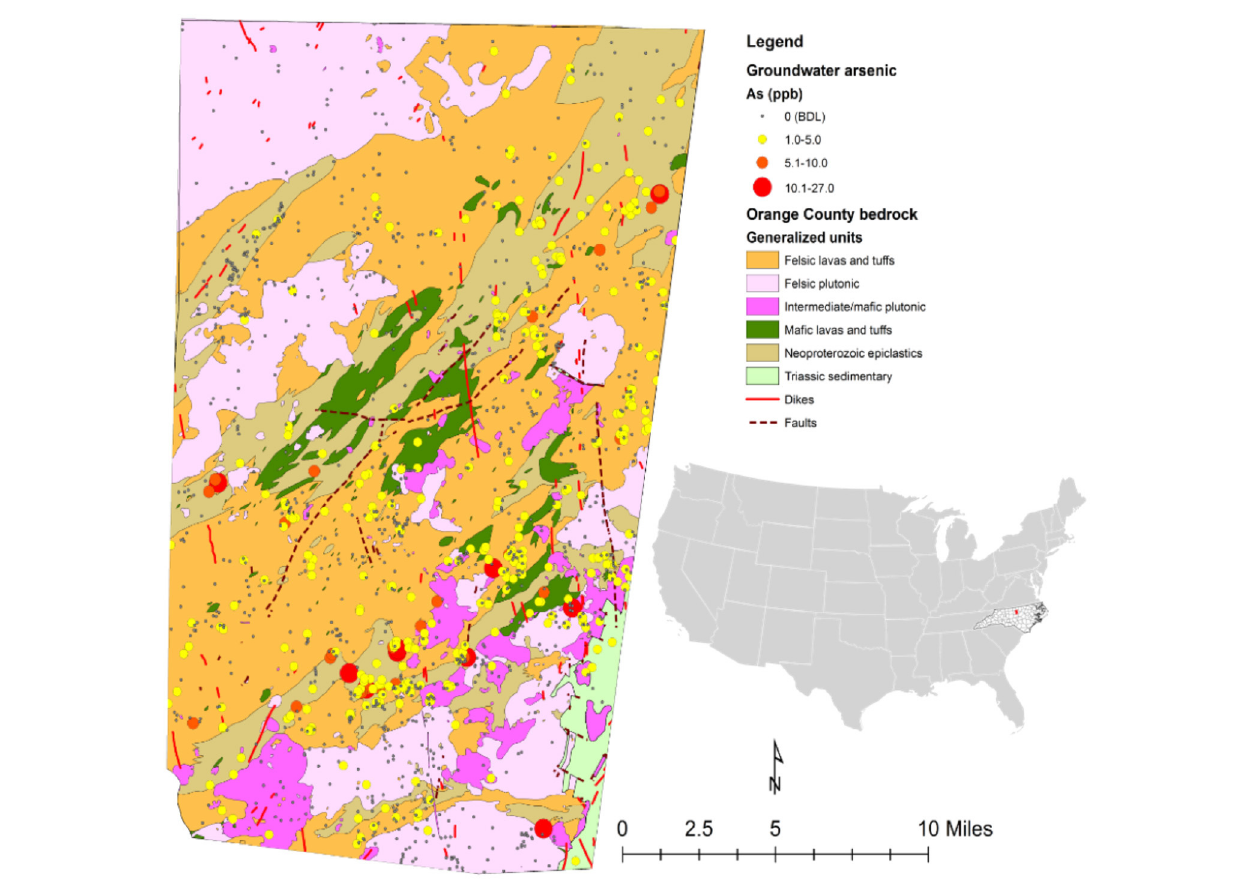
FIGURE 2 | Generalized geologic map of Orange County with the well data of arsenic concentrations from groundwater sample data obtained through the NC DHHS. The red dot on the US map indicates the location of the Orange County.